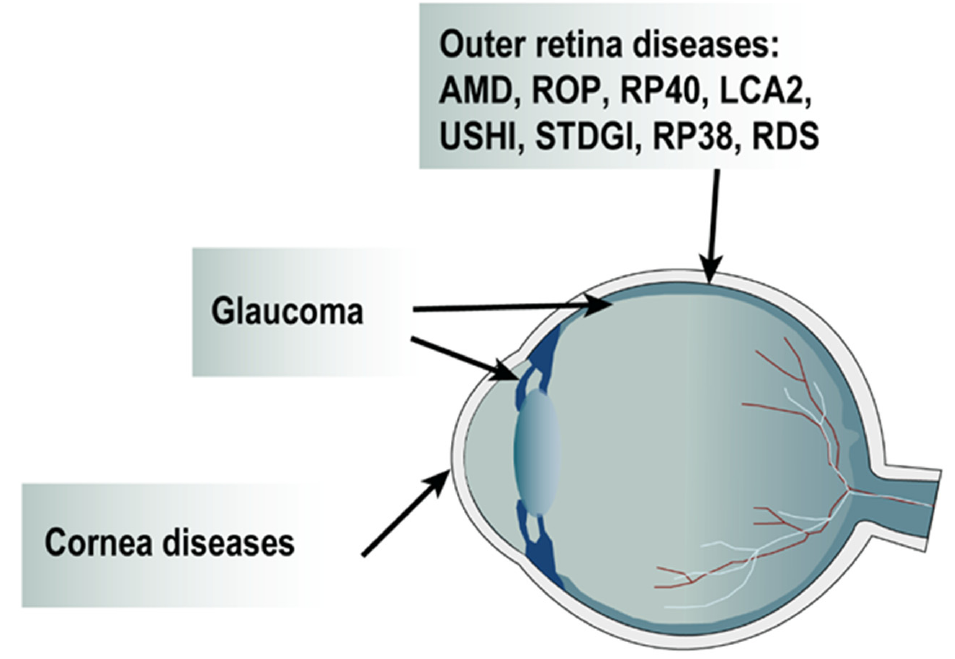
Figure 4. Diseases currently targeted by LV. LV treatments are evaluated for clinical application to treat several diseases of the anterior and posterior ocular compartments.